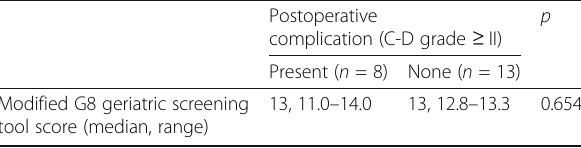
Table 4 Comparison of the modified G8 geriatric screening tool scores in patients with or without postoperative complications